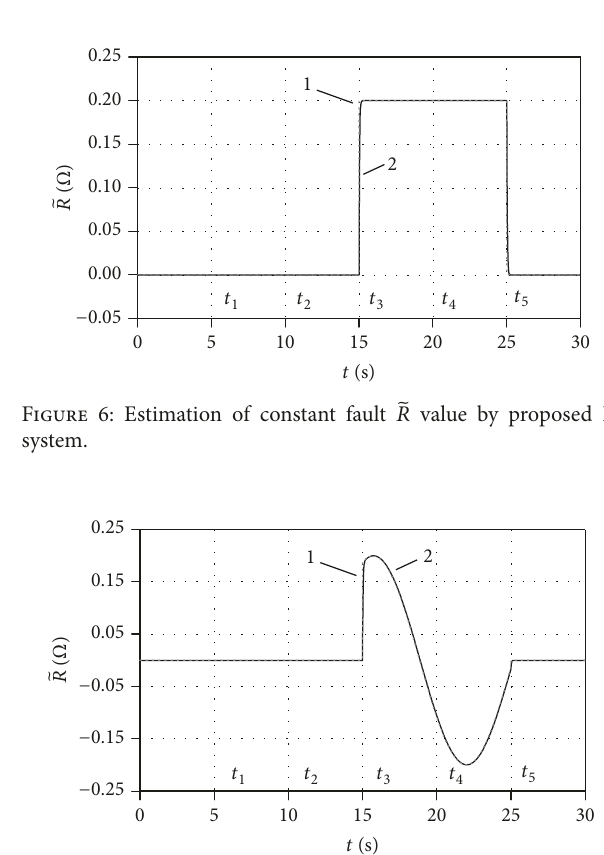
Figure 2: Estimation of constant fault system.